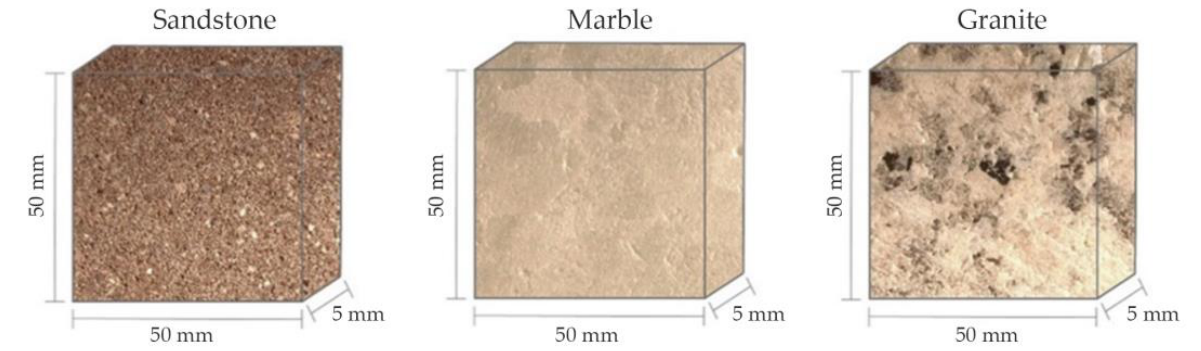
Figure 4. Samples of the three stone materials after cutting.